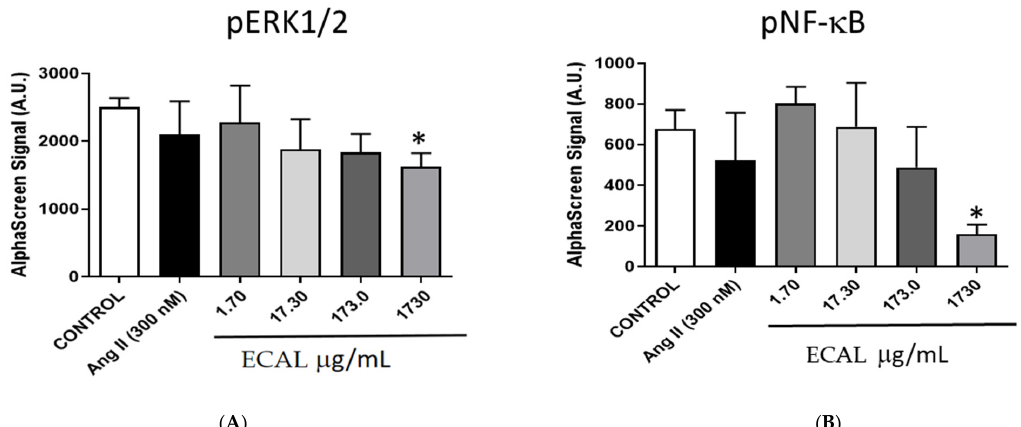
Figure 4. Hydroethanolic extract of C. album leaves (ECAL) effects on ERK and NF ‐ kB pathways in MDA ‐ MB ‐ 231 cells. ( A ) Phosphorylated ERK1/2 and ( B ) Phosphorylated NF ‐κ B, measured in the presence of negative control, positive control (angiotensin II (Ang II), 300 nM) and with increasing concentrations of ECAL (1.7–1730 μ g/mL). Significant differences from the values obtained in control: * p < 0.05 (One ‐ way ANOVA followed by post hoc Dunnett’s multicomparison t ‐ test. Nuclear factor kappa ‐ B (NF ‐κ B) has been described to be involved in the blockage of apoptosis and cell proliferation [17]. Thus, we evaluated the ability of ECAL to suppress the activation of NF ‐κ B. ECAL showed an inhibition of total NF ‐κ B compared to values observed in control MDA ‐ MB ‐ 231 cells (data not shown). In addition, the phosphorylated NF ‐κ B measurement demonstrated that increasing concentrations of ECAL (1.7–1730 μ g/mL) downregulated the phosphorylated forms of NF ‐κ B, which are known to be in ‐ volved in the translocation to nucleus.